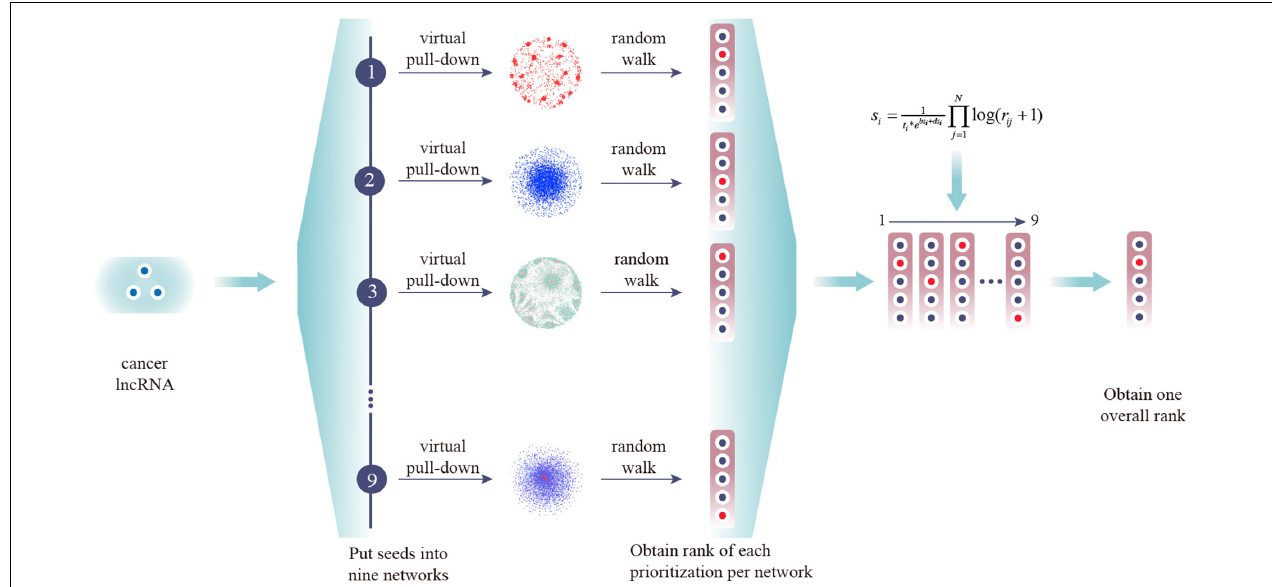
FIGURE 2 | Experimental scheme of CLING. First, experimentally supported cancer lncRNAs were extracted from Lnc2cancer and virtually pulled down into nine lncRNA-centric networks. Next, all candidate lncRNAs were ranked in one prioritized list for each network based on the RWR algorithm. Finally, all separate prioritization results and lncRNA topological properties were integrated into an overall